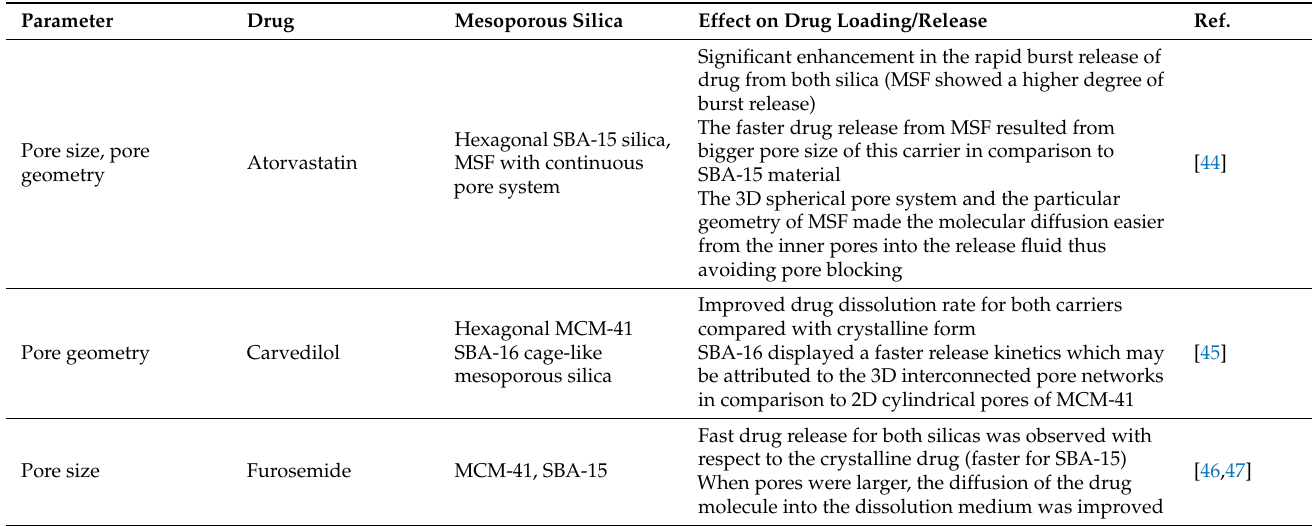
Table 1. The properties of mesoporous materials influencing the drug loading and